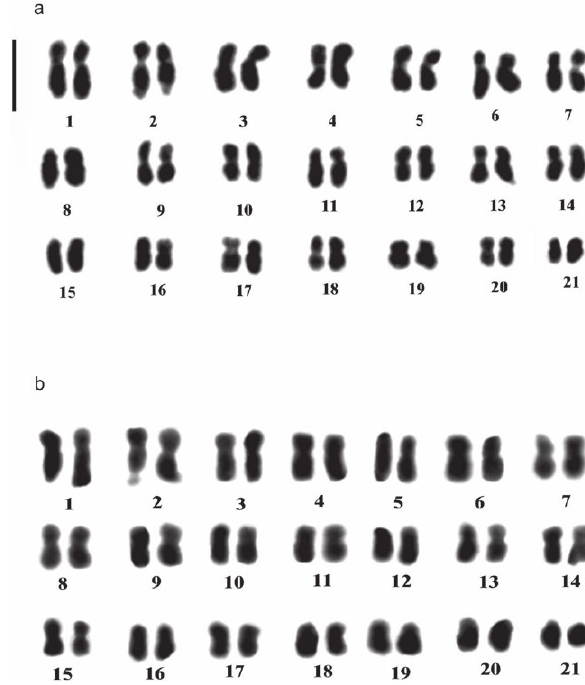
Figure 2. Diploid karyotypes of Platanthera chlorantha (a) and P. algeriensis (b). Bar = 5